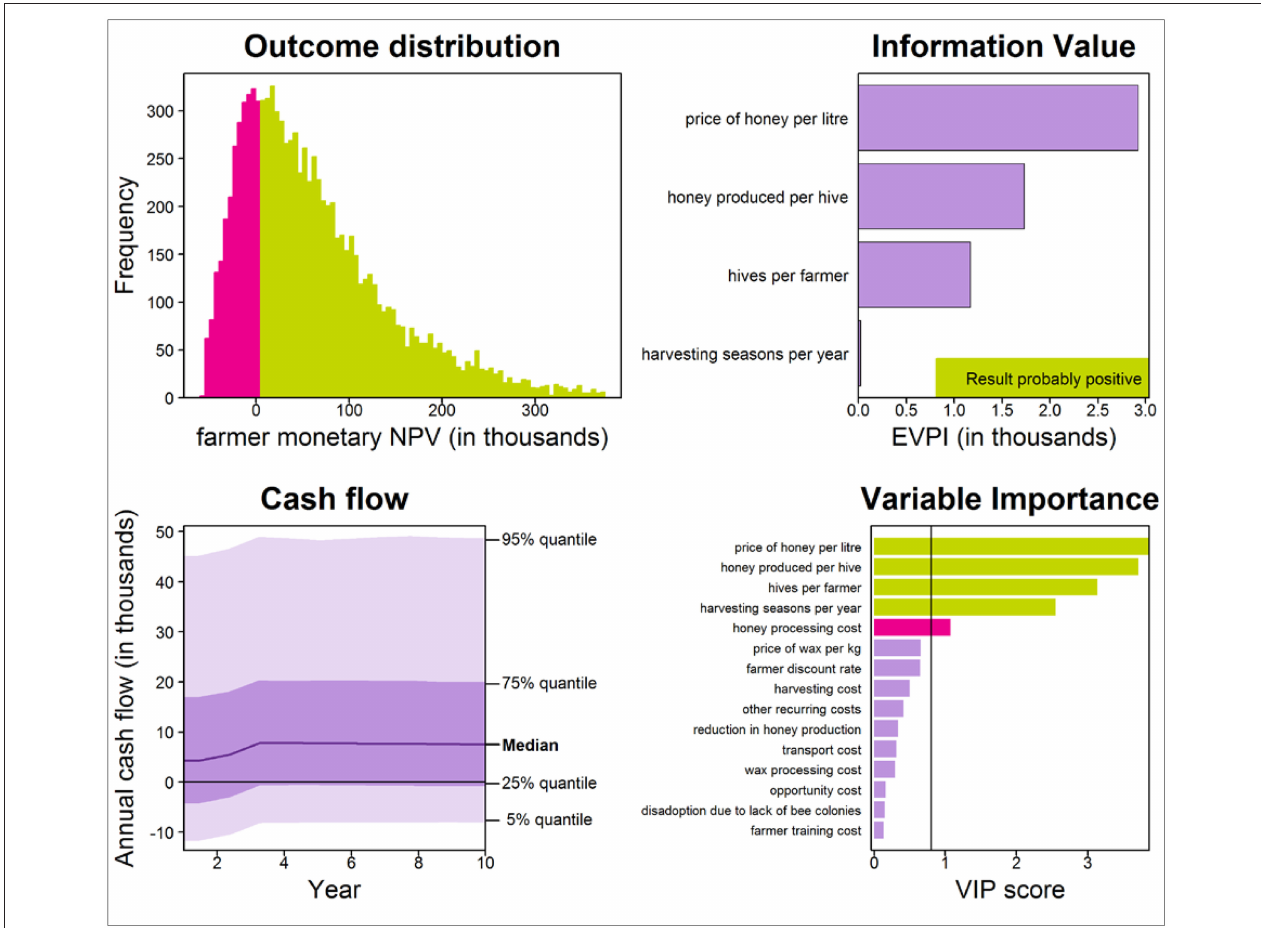
FIGURE 4 | Projected outcome distribution (top left), high-value variables (EVPI; top right), project cash flow (bottom left) and important variables (determined by PLS regression; bottom right) for a farmer practicing beekeeping in Witu, Kenya. Results were produced through Monte Carlo simulation (with 10,000 model runs) of project performance over 10 years. Red and green bars in the outcome distribution indicate positive and negative values, respectively. In the PLS plot, green bars indicate positive correlations of uncertain variables with the outcome variable, while red bars indicate negative